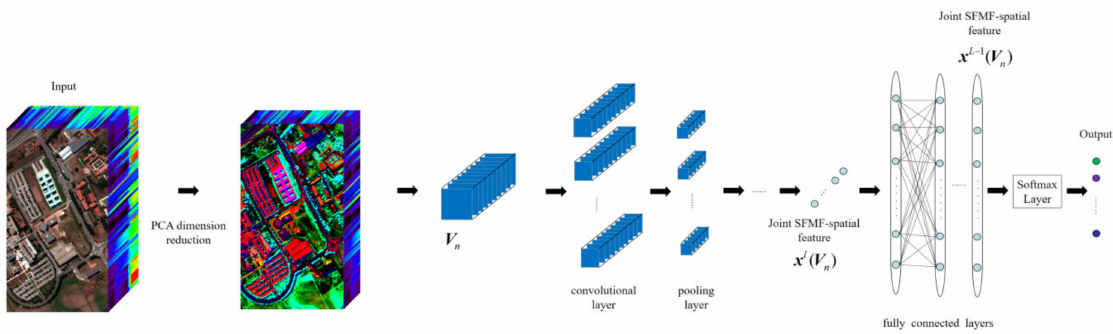
Figure 3. Architecture of 3-D